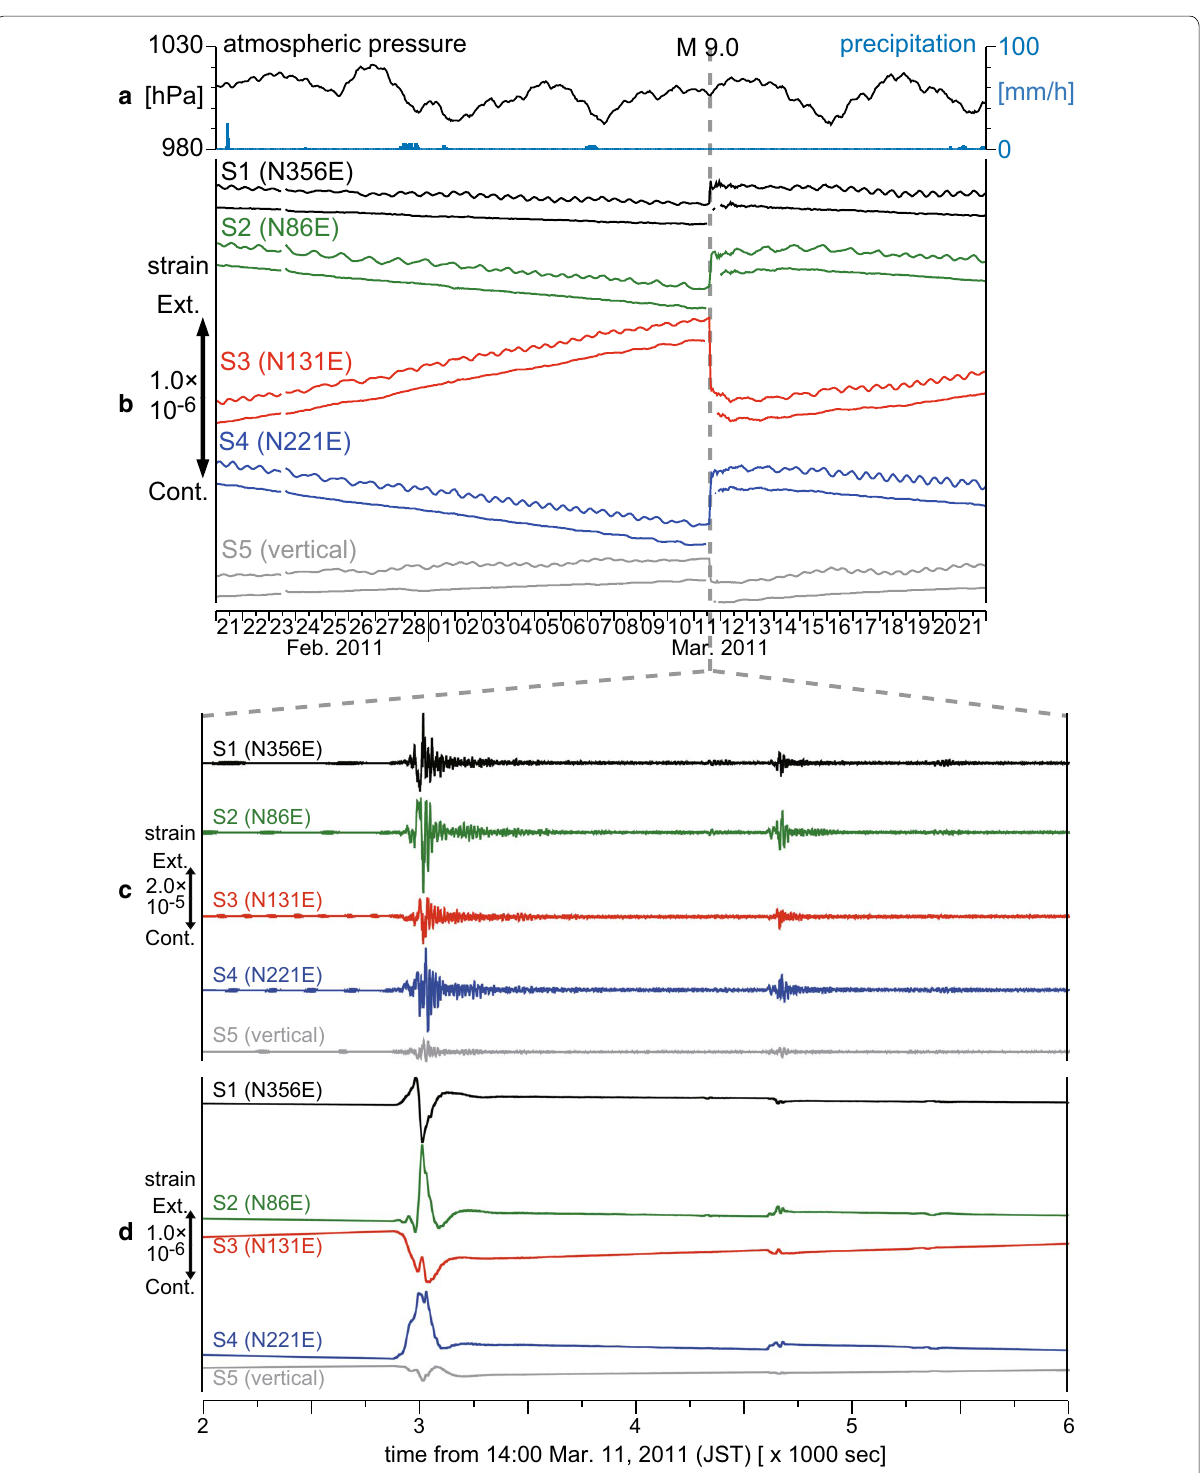
Fig. 1 Examples of time-series data from station 1 TYE (location in Fig. 3) around the time of the 2011 Tohoku-Oki earthquake. a Hourly values of atmospheric pressure and precipitation. b Hourly values of strain showing the original (upper) and corrected (lower) data. For data correction, tidal changes and the effects of atmospheric loading were removed by using the BAYTAP-G program (Tamura et al. 1991). c Enlargement of the records shown in ( b ) around the time of the mainshock. The sampling rate was 20 Hz. The linear trend has been removed. d The same data after application of a low-pass filter of 250